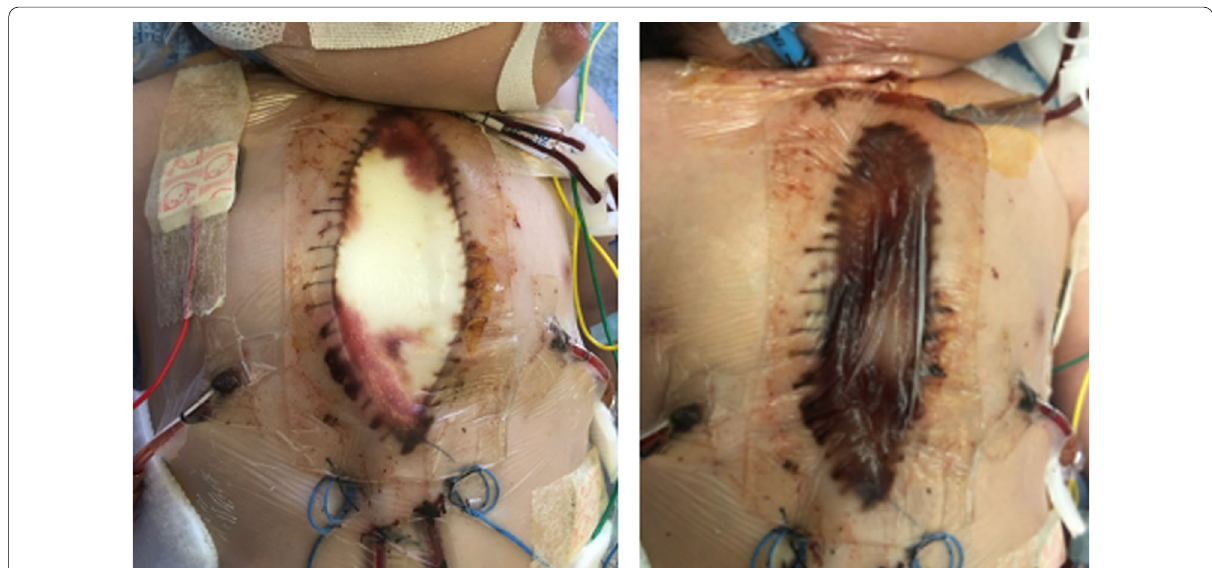
Fig. 2 The hydrophilic material initially white (left: one day after surgery) absorbed leachate liquid and turned into gel (right: 3 days after